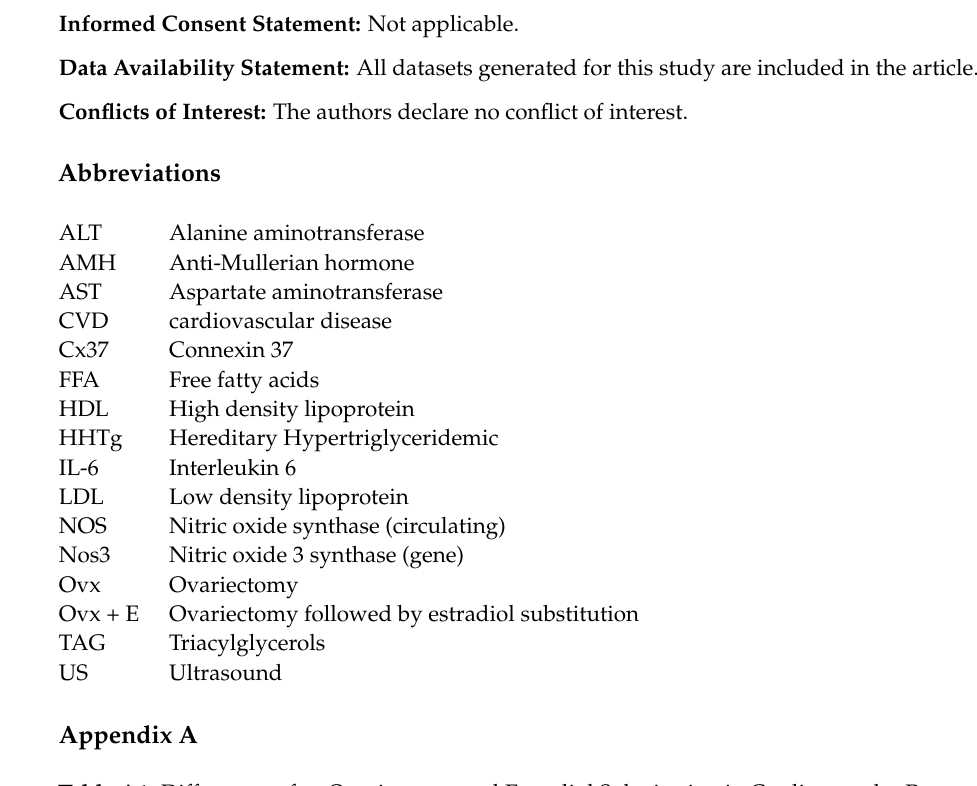
Table A1. Differences after Ovariectomy and Estradiol Substitution in Cardiovascular Parameters in Hereditary Hypertriglyceridemic